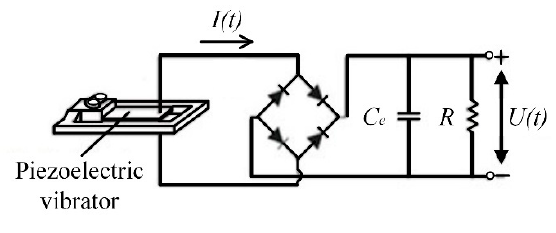
Figure 14. Classic energy harvesting circuit.